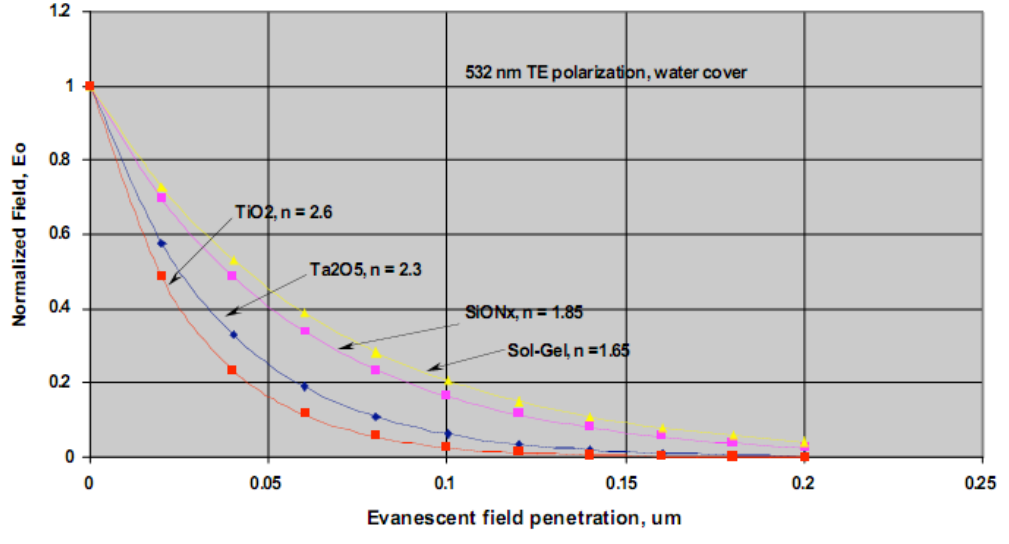
Figure 10. Comparison of the evanescent field decay in different waveguide platforms. Details in Section 6 of the